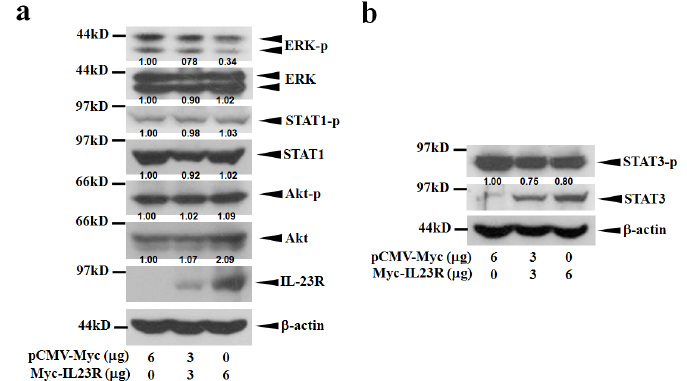
Figure 6. The mitogenic signaling pathways are repressed by IL-23R in 293ET